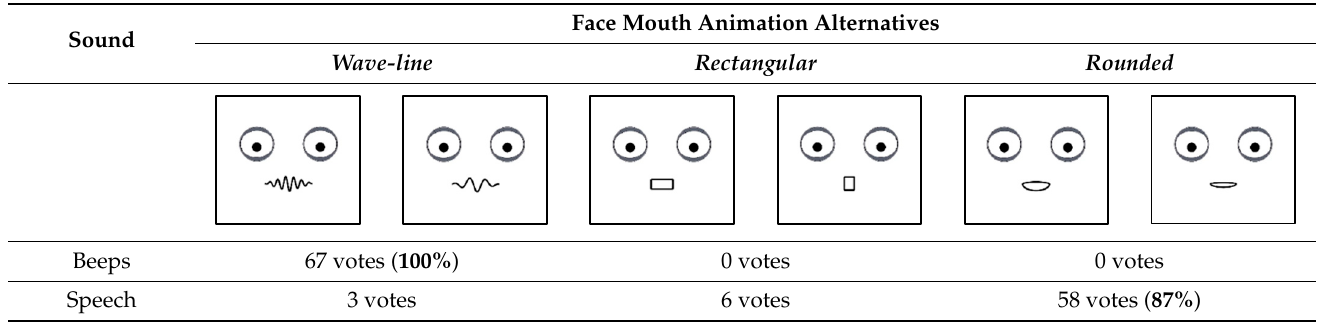
Table 7. Alternatives considered to implement the animation of the mouth and votes received.